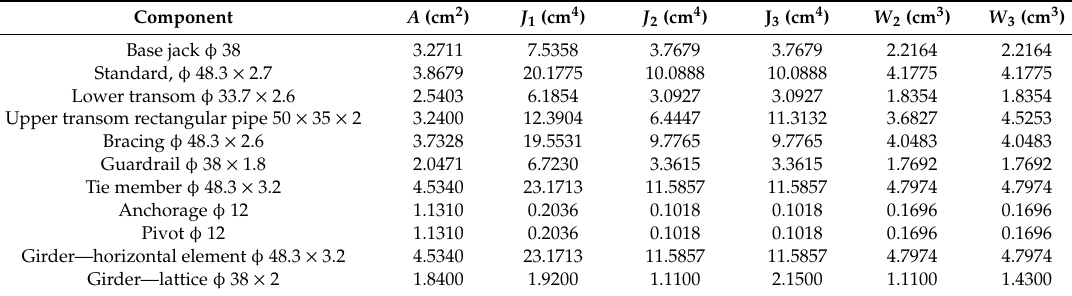
Table 1. The geometrical characteristics of element